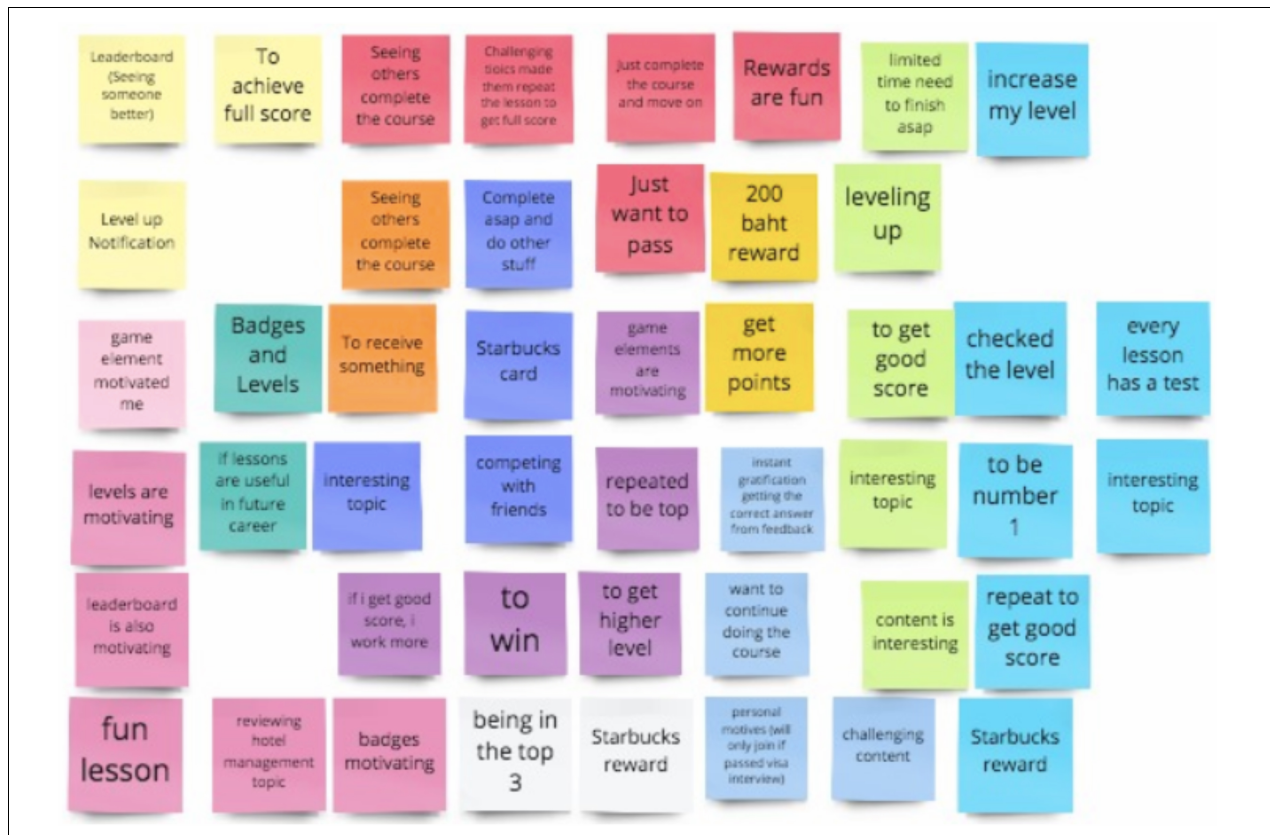
FIGURE 4 | Excerpt of coded keywords related to perceived motivators in the gamified online